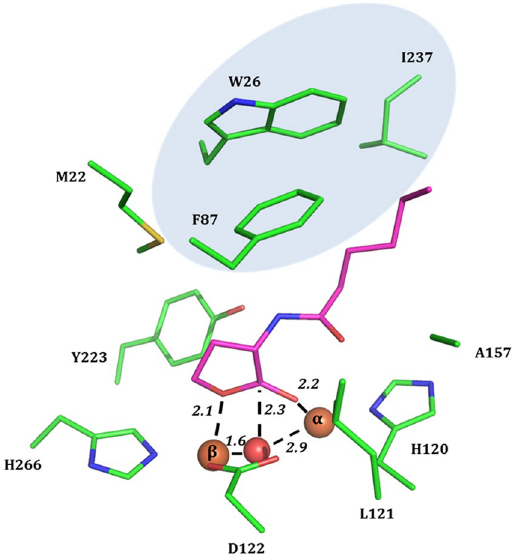
Figure 8. AaL complex with a C6-AHL. Active site residues (green sticks) are shown and interactions between the bound C6-AHL (purple sticks), metal cations, and the bridging water molecule are highlighted as black dashes and distances are indicated in Ångstroms. The hydrophobic patch accommodating the AHL acyl chain is highlighted with a light blue